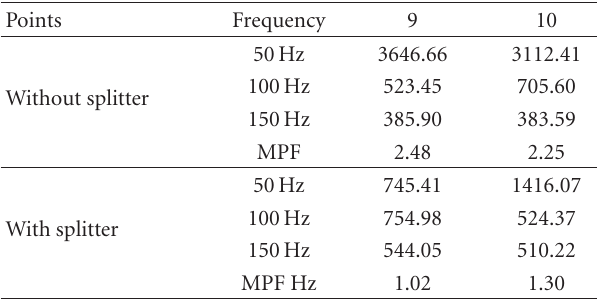
Table 5: Amplitude of frequency domain and MPF at outlet pipe monitoring points (see Figure